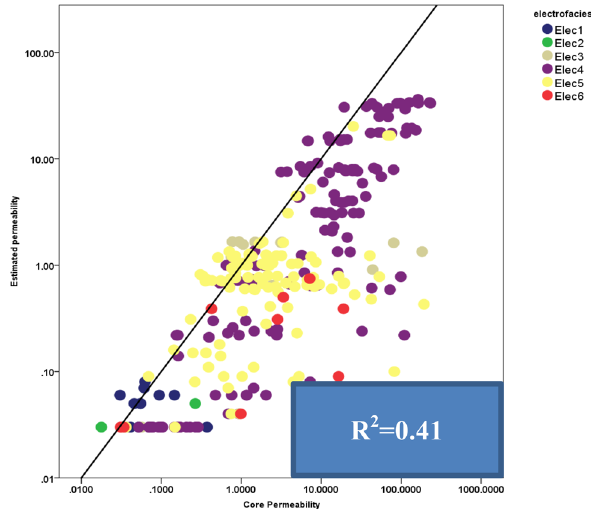
Fig. 23 Cross plot of results from estimated permeability versus core permeability with feature engineering